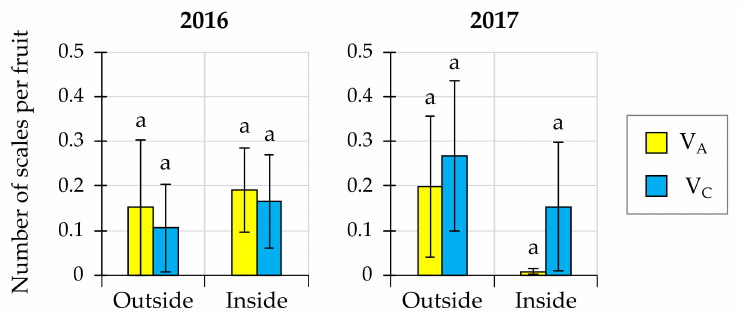
Figure 6. Number of Aonidiella aurantii scales per fruit (mean value with standard error bar) at two depths of the canopy (outside, inside), for both treatments (V A : adjusted volume, V C : conventional volume) and two years (2016 and 2017) considering the plots (P1–P7) as repetitions. Different letters above the bars indicate significant differences (Kruskal-Wallis test, p < 0.05).